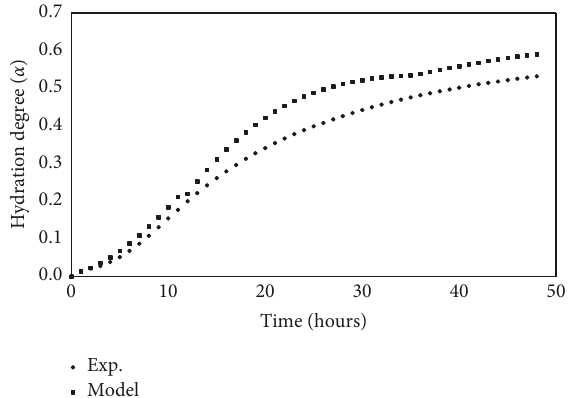
Figure 10: Experimental results of the hydration degree with the assumed kinetic model for sample C20SZ.